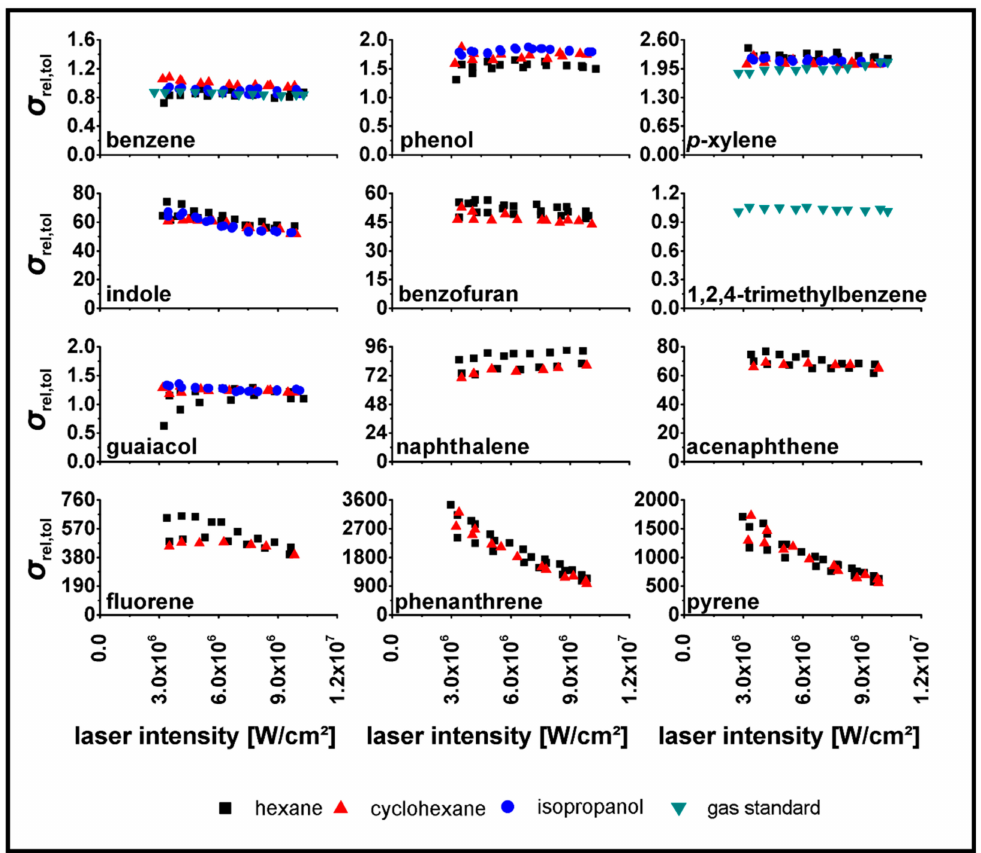
Figure 7. Relative REMPI cross sections ( σ rel,tol ; toluene was used as a reference substance) at 248 nm. For 1,2,4-trimethylbenzene, only data of the gas standard were